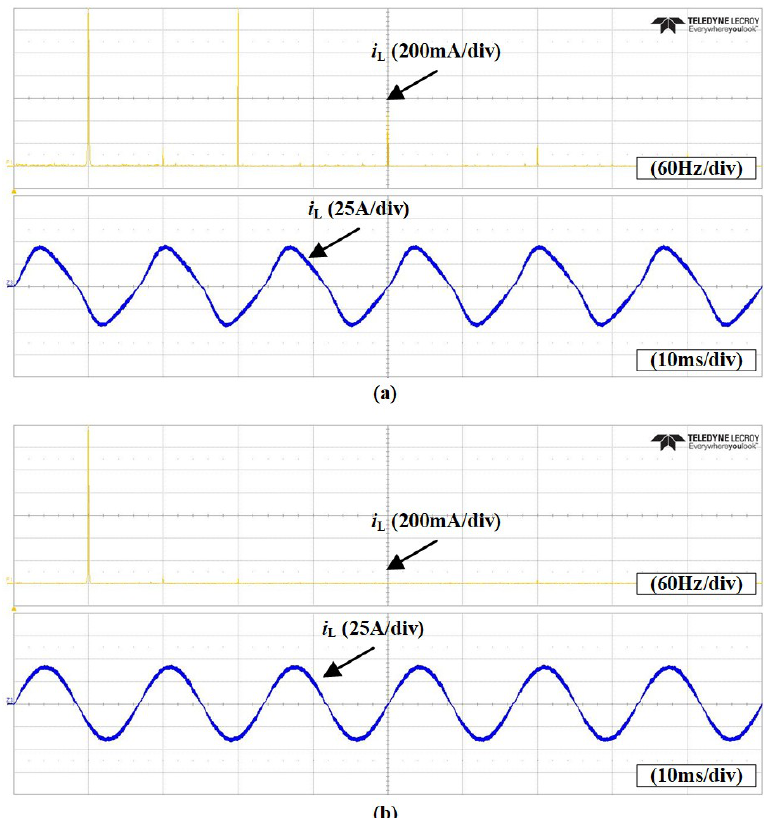
Figure 16. Experimental results of lower-order harmonics compensation method: Waveforms of grid current and FFT analysis ( a ) without and ( b ) with the proposed compensation method.